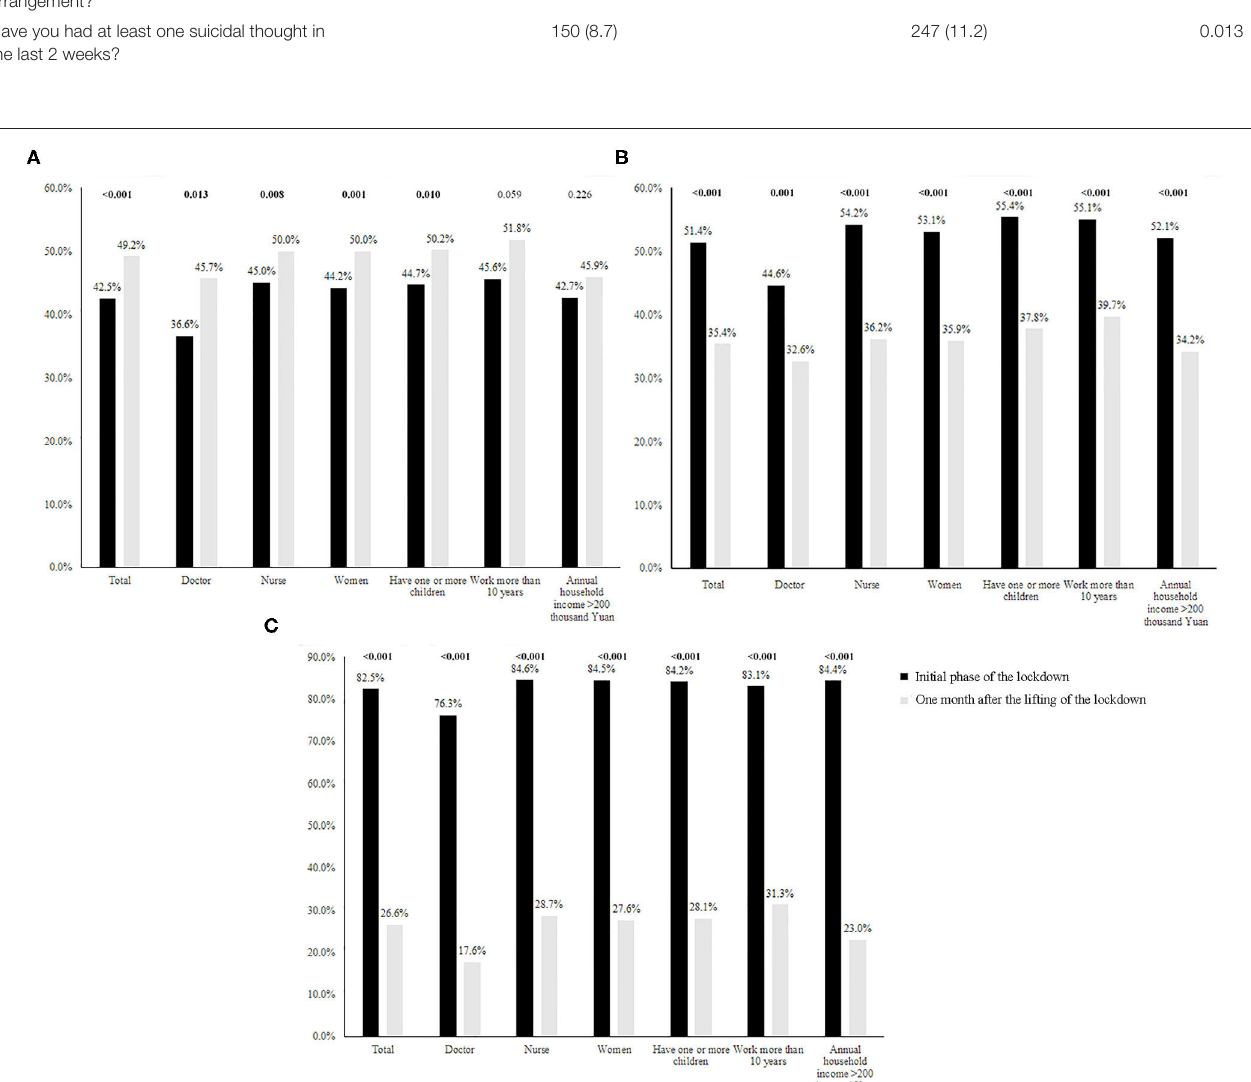
Frontiers in Psychiatry |